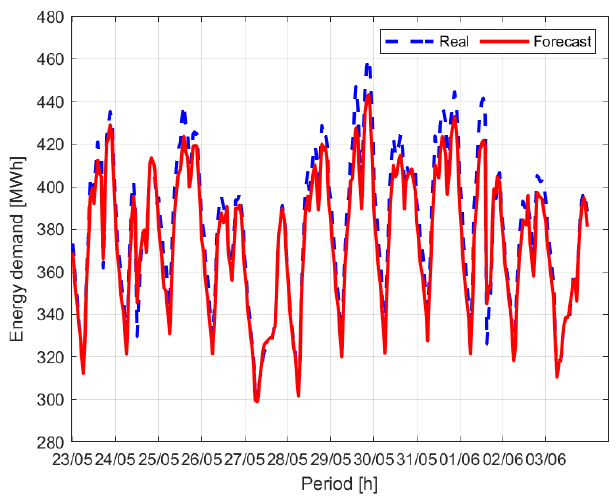
Figure 18. Forecasting energy demand for Market 2.